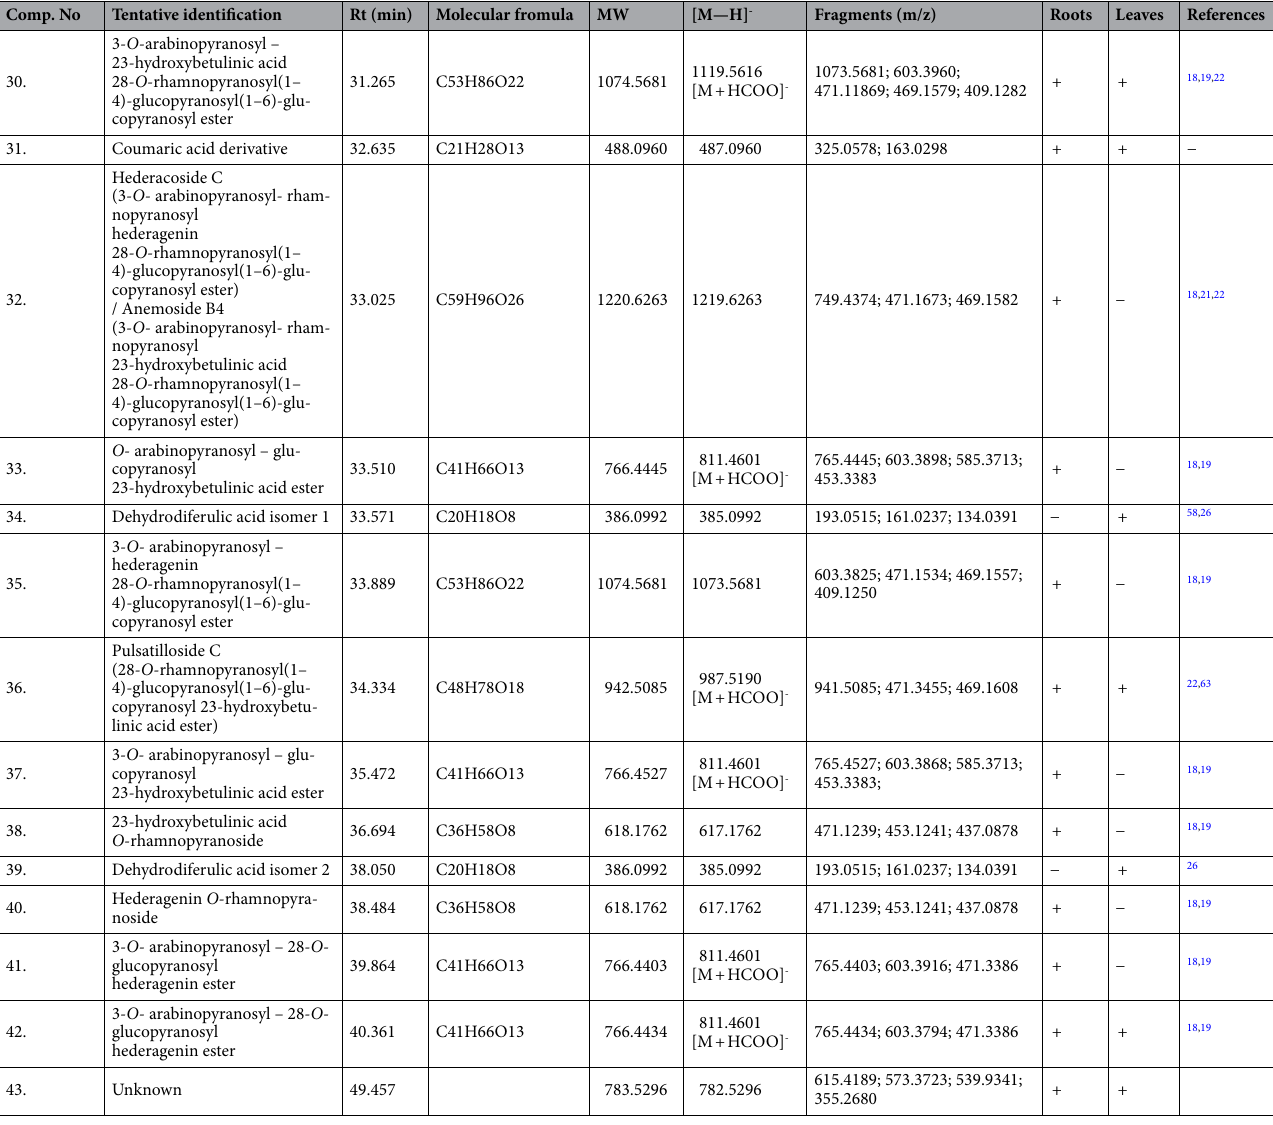
Table 4. Chemical composition of P. patens